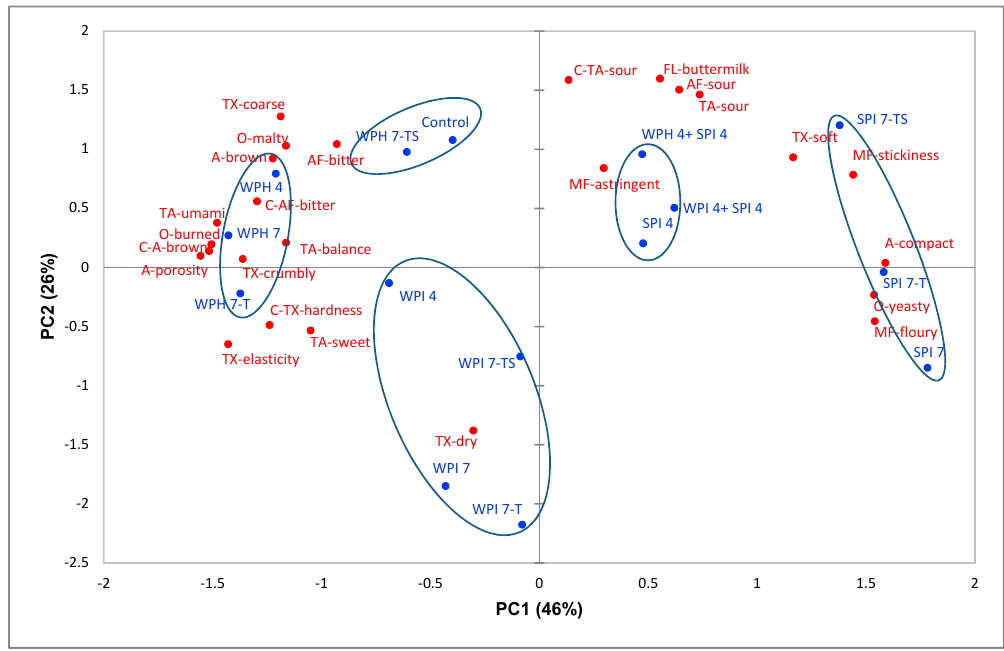
Figure 2. Principal component analysis bi ‐ plot of sensory attributes (red labels) and rye bread samples (blue labels). PC1 = first principal component; PC2 = second principal component. Red labels: sensory attributes; C = attributes for crust; attributes without “C” are attributes for crumbs; O = odor attributes; A = appearance attributes; TA = taste attributes; TX = texture attributes; FL = flavor attributes; MF = mouthfeel attributes; and AF = after taste attributes. Blue labels: rye bread samples; numbers indicate amount of added protein (4 = 4%, and 7 = 7%). T = texture ‐ modified samples; TS = texture and taste ‐ modified samples.